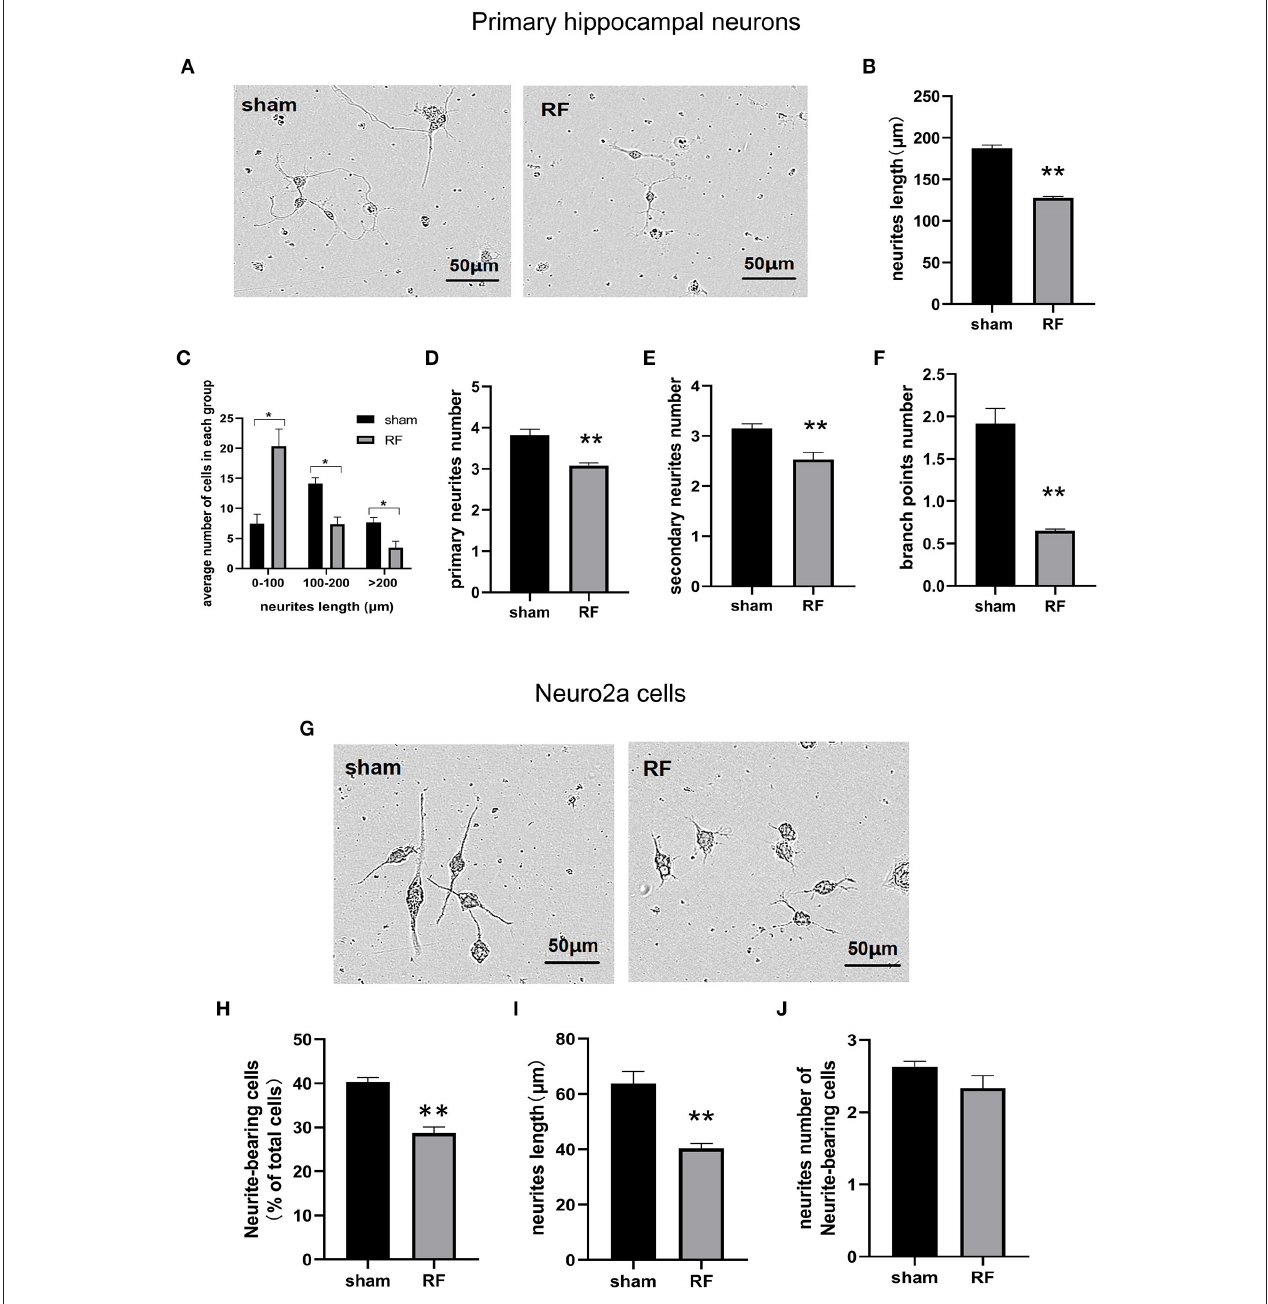
FIGURE 2 | Effects of RF-EMR exposure on neurite outgrowth in neuronal cells. Primary hippocampal neurons (A–F) and Neuro2a cells (G–J) were exposed to 1,800 MHz RF-EMR at 4 W/kg for 48h. Morphological parameters were identified according to the description in the methods. Representative images of primary hippocampal neurons (A) and Neuro2a cells (G) were taken under a (20 × ) Leica microscope, and pictures were analyzed with ImageJ software. (B) shows the total neurite length per primary hippocampal neuron, (C) shows the number of cells in the groups with a total neurite length per primary hippocampal neuron larger than 100 µ m, (D,E) shows the primary and secondary neurite numbers per primary hippocampal neuron, (F) shows the branch point number per primary hippocampal neuron, (H) shows the neurite-bearing cell percentage in Neuro2a cells, (I) shows the total neurite length per Neuro2a cell, and (J) shows neurite number of neurite-bearing Neuro2a cells after RF-EMR exposure. * P < 0.05, ** P < 0.01, Student’s t -test. Scale bar: 50 µ m.